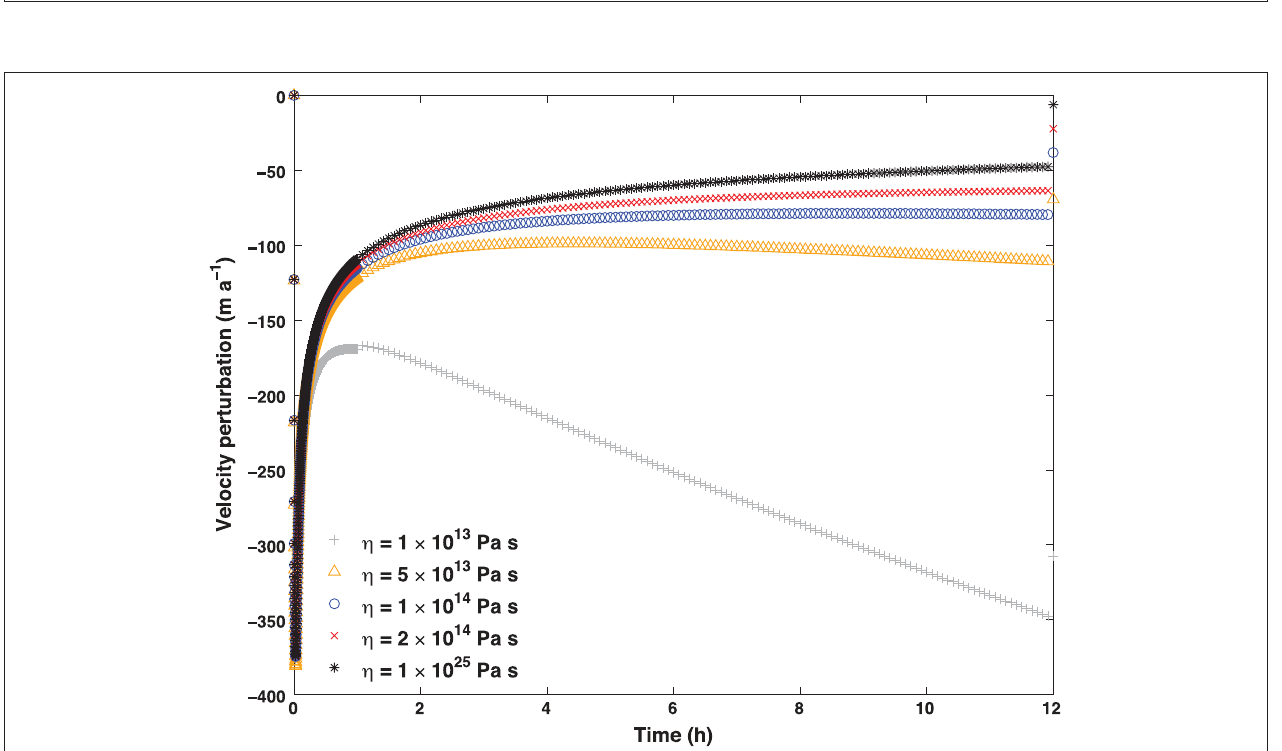
FIGURE 6 | Along-flow velocity perturbation at center of domain (over sticky spot), showing effect of varying viscosity. Results for η ≥ 1 × 10 16 Pa s not shown due to overlap with the η = 1 × 10 25 Pa s experiment, which is an artificially high value chosen to obtain purely elastic behavior.